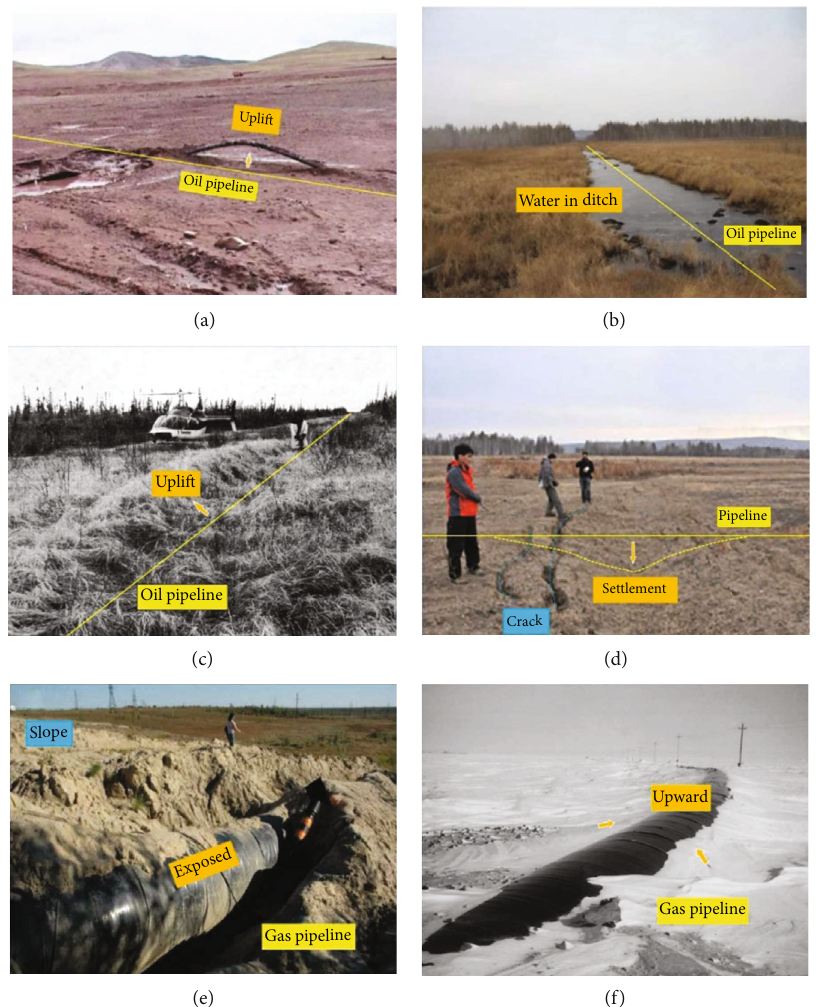
Figure 1: Frost hazards along the buried energy pipelines in permafrost regions: (a) uplift of the buried Golmud-Lhasa product oil pipeline above the ground modi fi ed by [3]; (b) water pond in thaw subsided ditch along the China-Russia Crude Oil Pipeline (CRCOP) from Mo ’ he to Daqing, Heilongjiang Province, Northeast China, modi fi ed by [4]; (c) bulged uplift of the Norman Wells Pipeline above the ground modi fi ed by [5]; (d) thaw settlement along the CRCOP in 2011 modi fi ed by [6]; (e) the exposed gas pipeline by landslide in western Siberia modi fi ed by [7]; (f) the fl oating up of the gas gathering system in northern Urengoy, Siberia, modi fi ed by